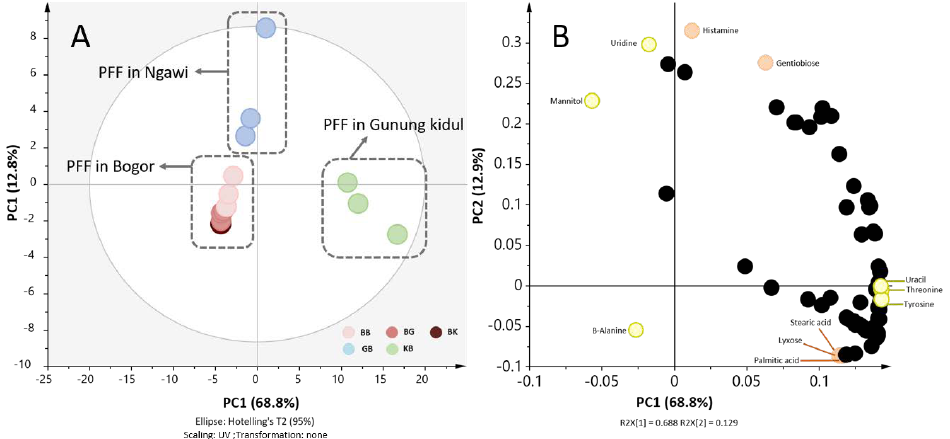
Figure 2. Principal component analysis (PCA) score and loading plot of cross fermentation experiments. Seventy-one annotated metabolites, n = 3. ( A ) PCA score plot shows separation between tempe in which PFF happened in Bogor, Ngawi, and Gunung Kidul along the PC1 (explain 68.9% of the variance), BB = PFF in Bogor, FF in Bogor; BK = PFF in Bogor, FF in Gunung Kidul; BG = PFF in Bogor, FF in Ngawi; GB = PFF in Ngawi, FF in Bogor; KB = PFF in Gunung Kidul, FF in Bogor. ( B ) PCA loading plot. Three representative metabolites contributing to the separation were mannitol, β -alanine, uridine, uracil, threonine, and tyrosine for PC1 and histamine, uridine, gentiobiose, stearic acid, lyxose, and palmitic acid for PC2.